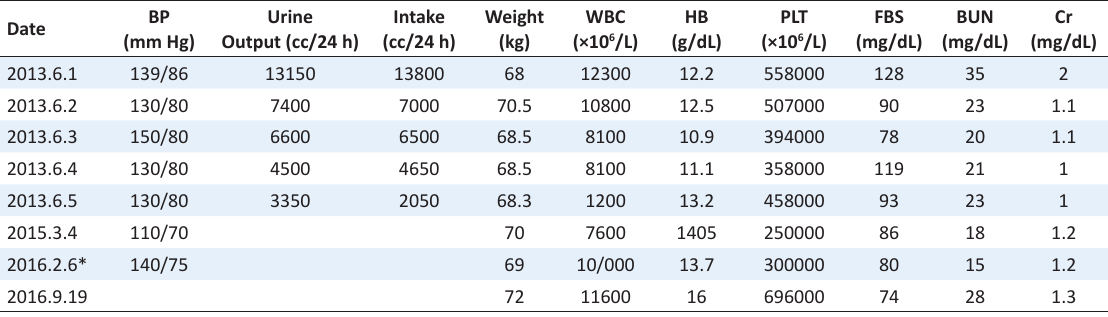
Table 2. Clinical status and laboratory tests after kidney transplantation